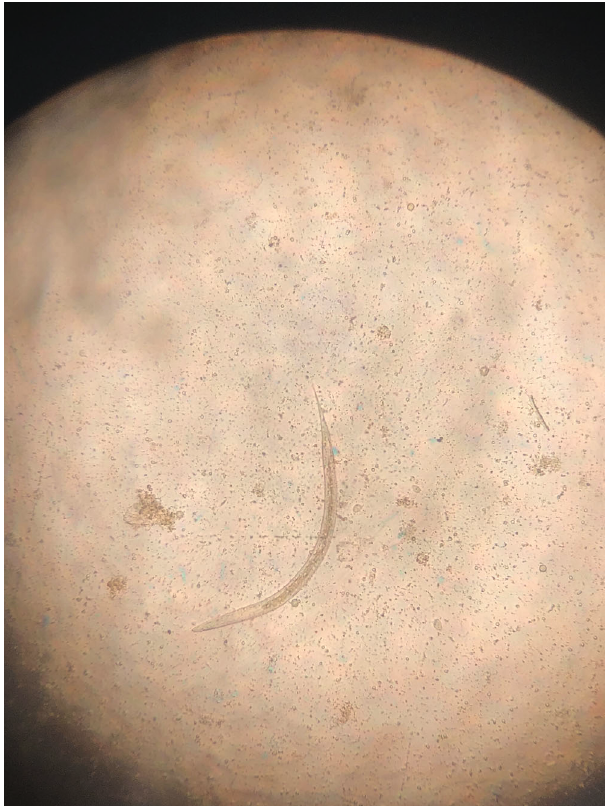
Figure 9: Oesophagostomum sp. (rounded head, medium-sized larva, long thin sheath tail, and 16 – 24 triangular intestinal cells). Third-stage